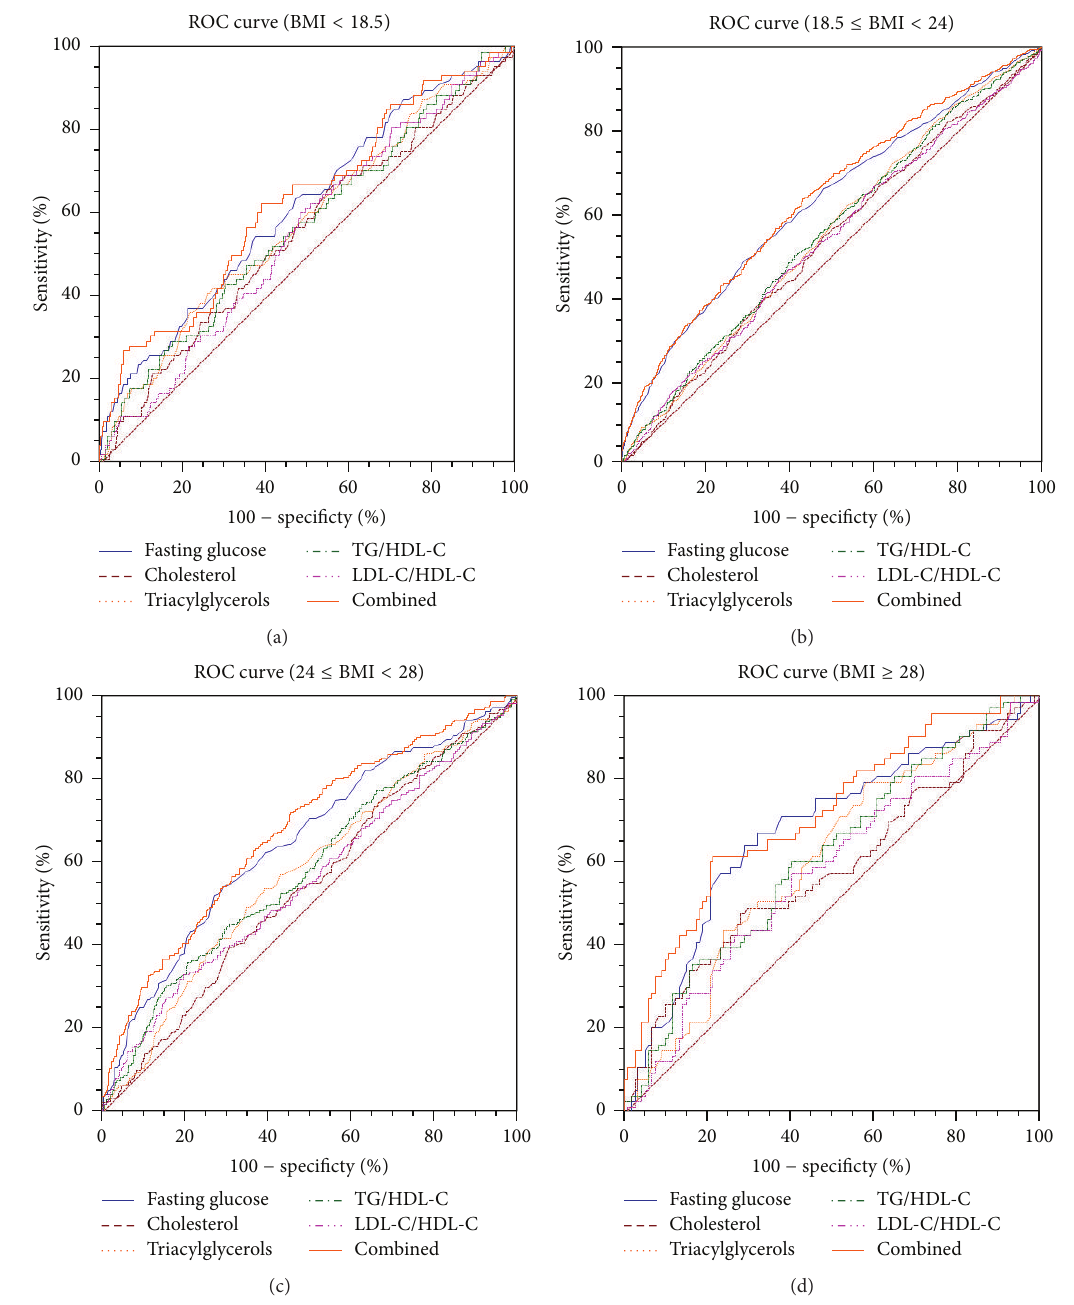
Figure 1: ROC curves of each factor and their combined ability to detect GDM, stratified by p-BMI. TG/HDL-C: triglyceride to high-density lipoprotein cholesterol ratio; LDL-C/HDL-C: low-density lipoprotein cholesterol/high-density lipoprotein cholesterol ratio.